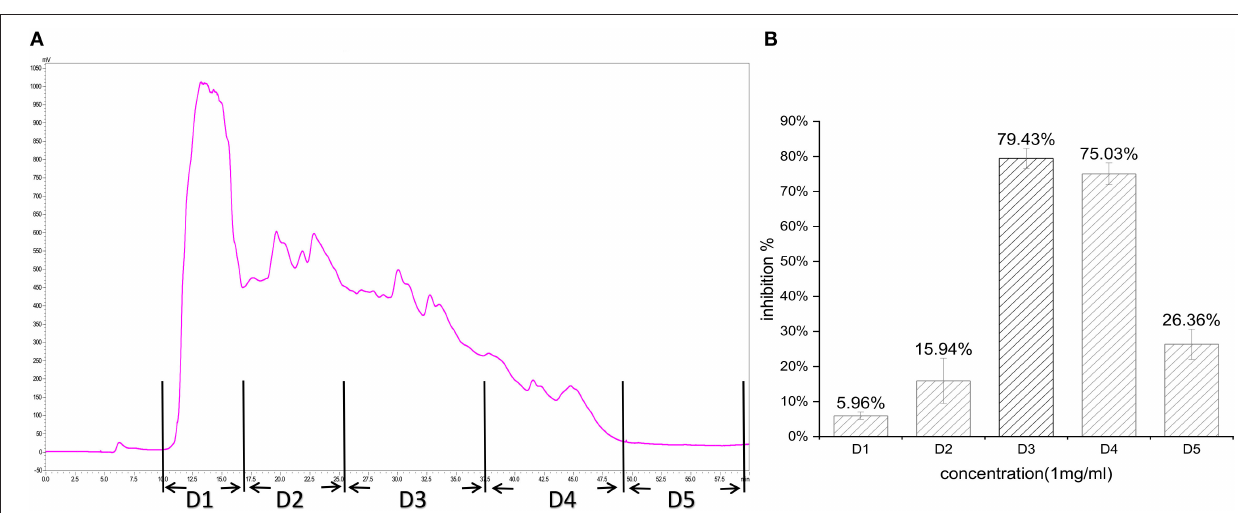
FIGURE 2 | (A) Reverse-phase HPLC chromatogram of first-step purification of RWLE peptides; (B) inhibitory activity of five pooled fractions (D1–D5).